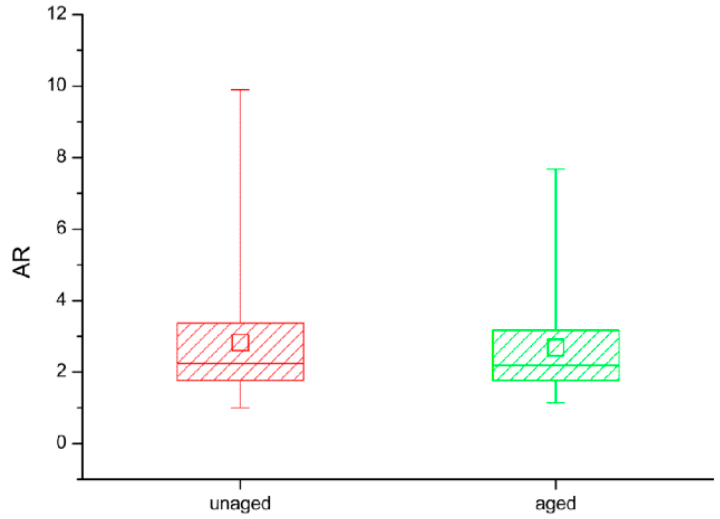
Figure 7. The shape of wear particles.